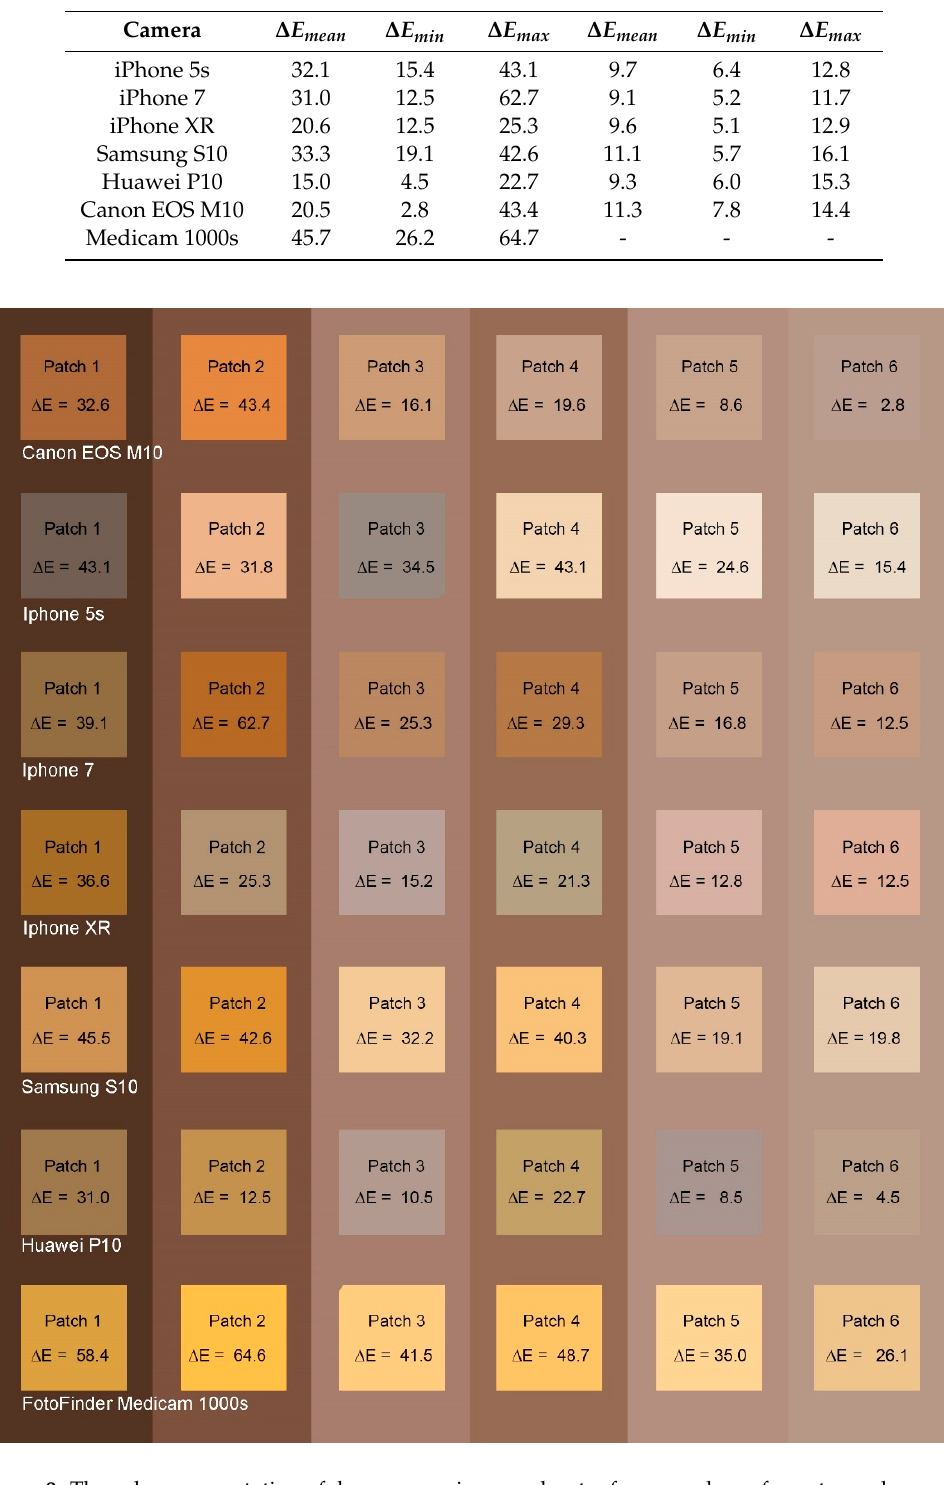
Figure 9. The colour presentation of dermoscopy images about reference colours for auto mode camera setting. The CIELAB Δ E colour distance of skin tone colour patches are set forth.